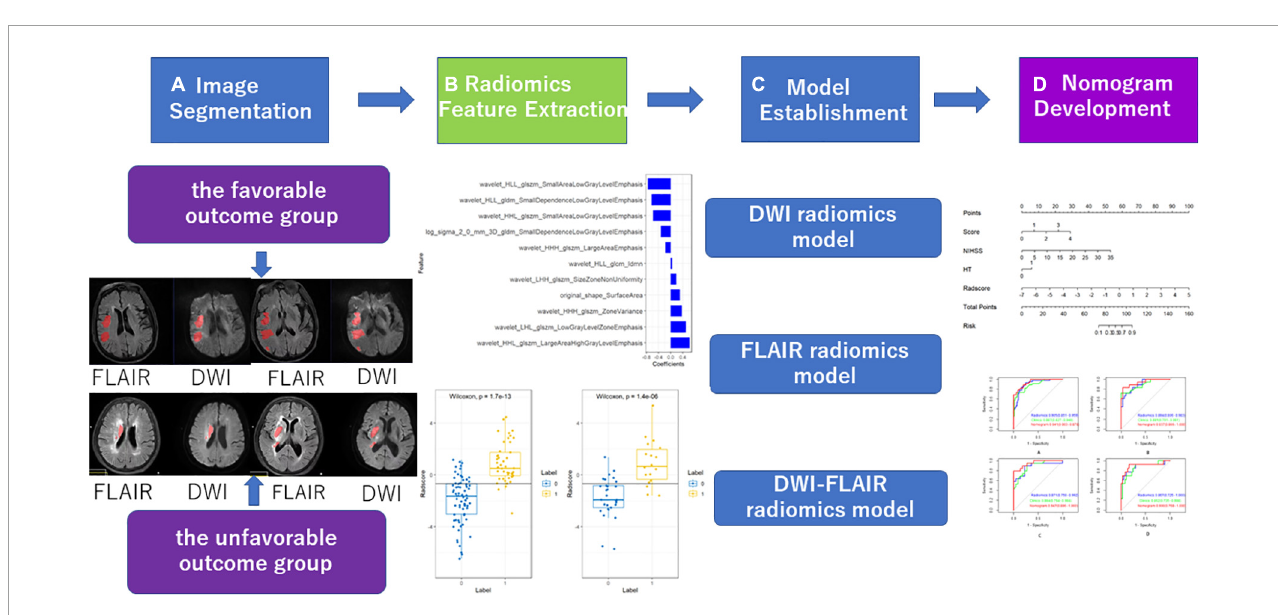
FIGURE2 Workflow of radiomics analysis of the